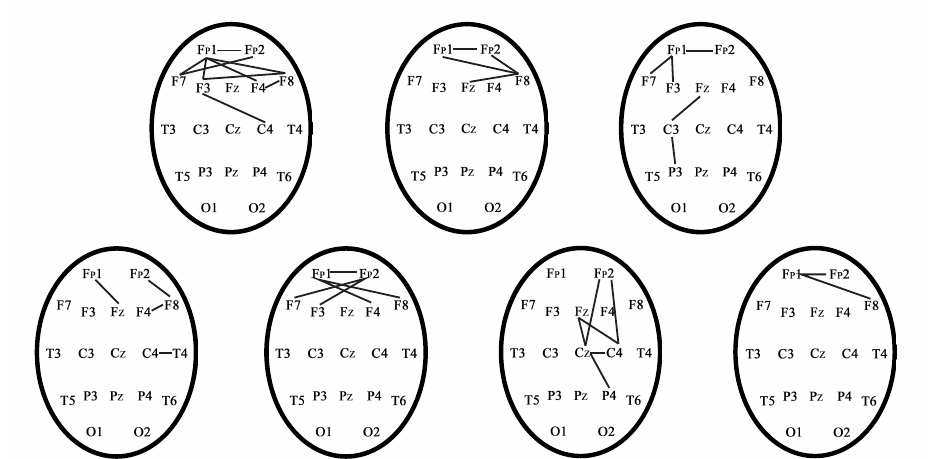
Figure 16. Phase-connected pairs of EEG channels of the control subjects during the EEG recording in the CT2